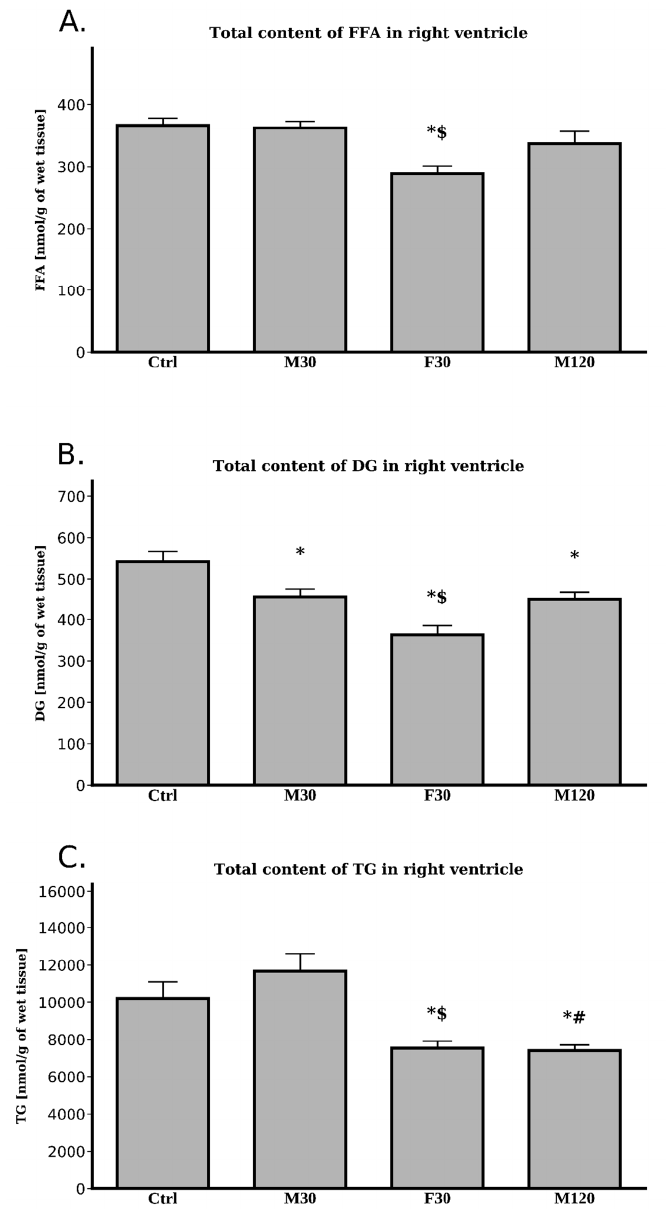
Figure 6. Effects of treadmill running on the total lipids content: FFA—free fatty acids ( A ) DG— diacylglycerol ( B ) TG—triacylglycerol ( C ) in the right ventricle. Data are expressed as mean ± SEM. * p < 0.05 difference vs. control (Ctrl); # p < 0.05 difference M120 vs. M30; $ p < 0.05 difference F30 vs. M30.